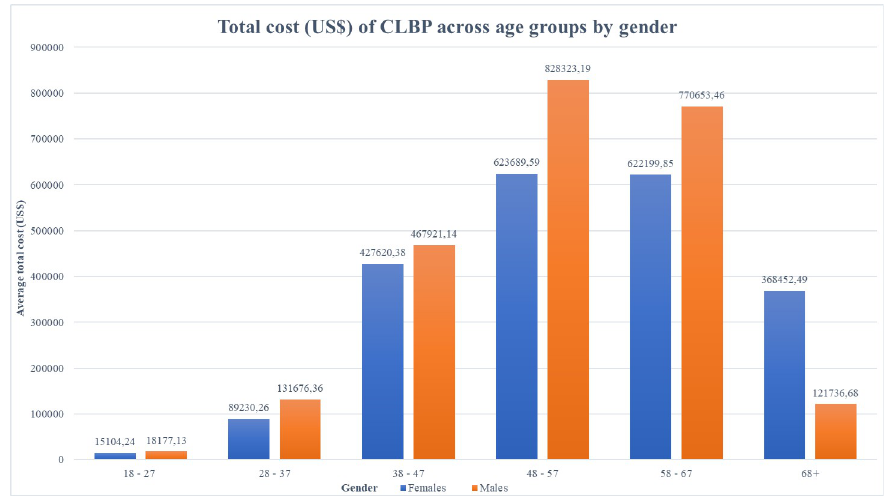
Fig 2. Total cost of CLBP across age groups by